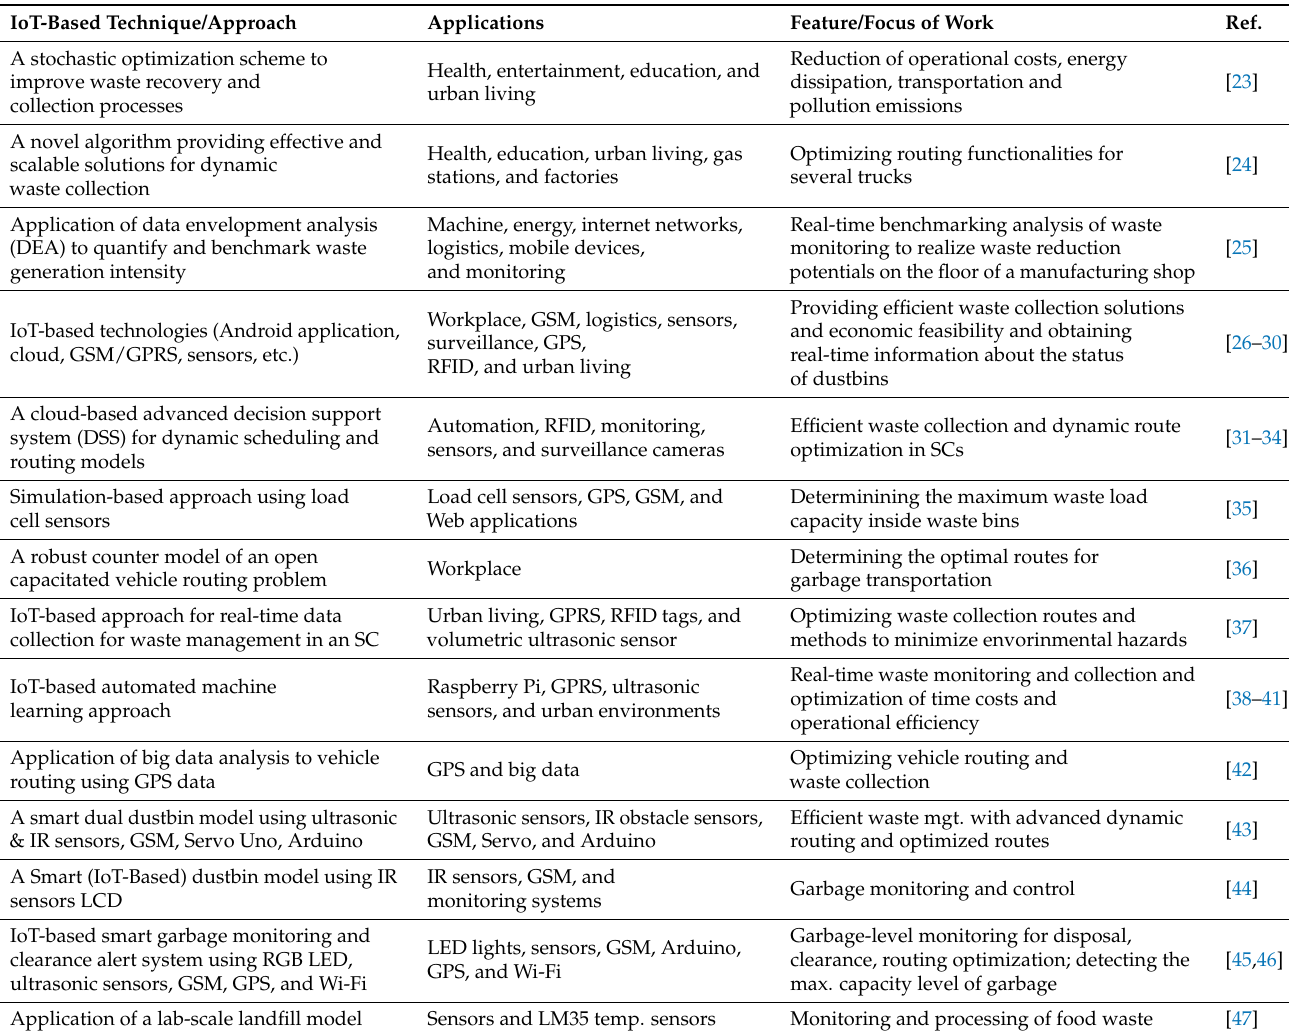
Table 1. Summary of previous works on IoT-based strategies for waste management in an